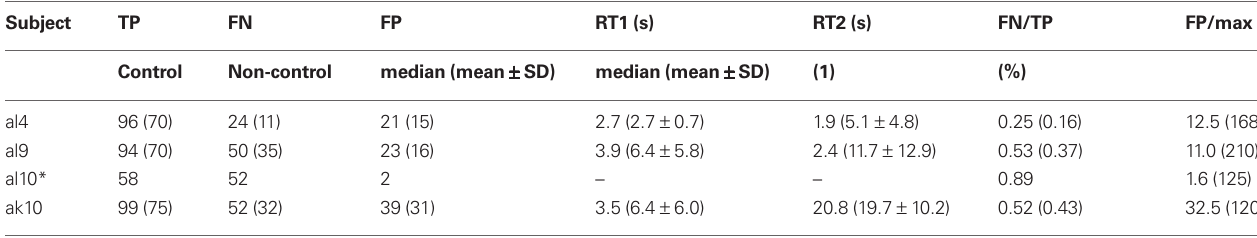
Table 5 | results of the evaluation procedure of four